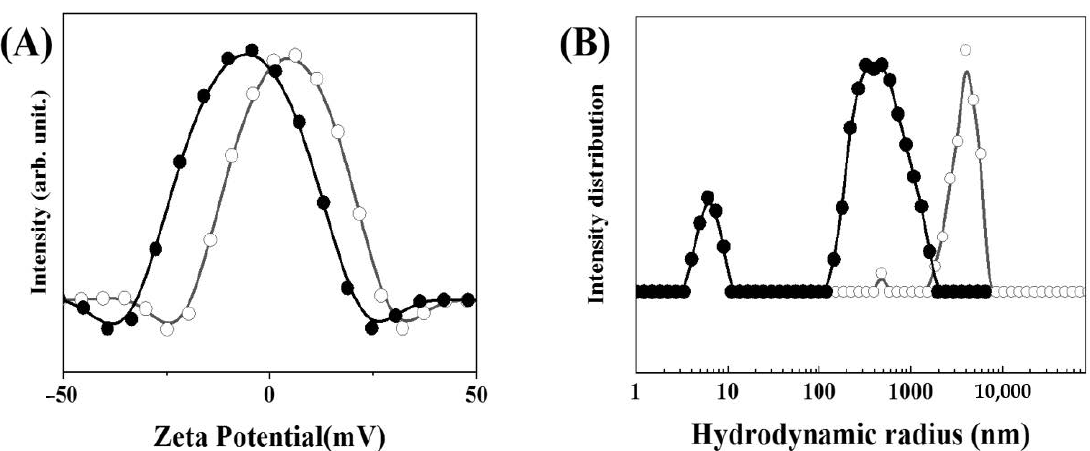
Figure 3. ( A ) Zeta potential distribution curves and ( B ) hydrodynamic radius distribution of MTX-LDH in neutral aqueous suspension (open circles) and simulated plasma condition (closed circles). Simulated plasma condition was prepared by dissolving fetal bovine serum in phosphate buffered saline. The concentration of sample suspension was set as ~0.1 mg/mL after optimization.